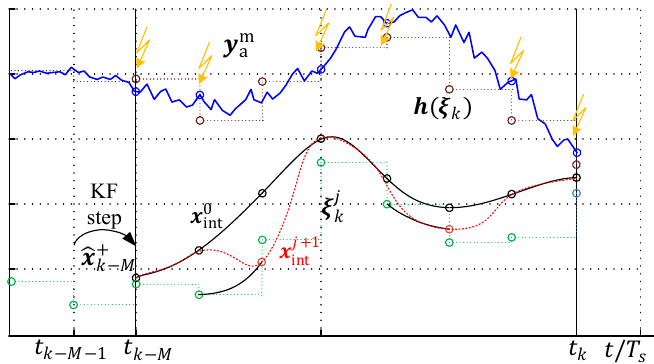
Figure 14. Moving horizon window with fragmentary measurements.